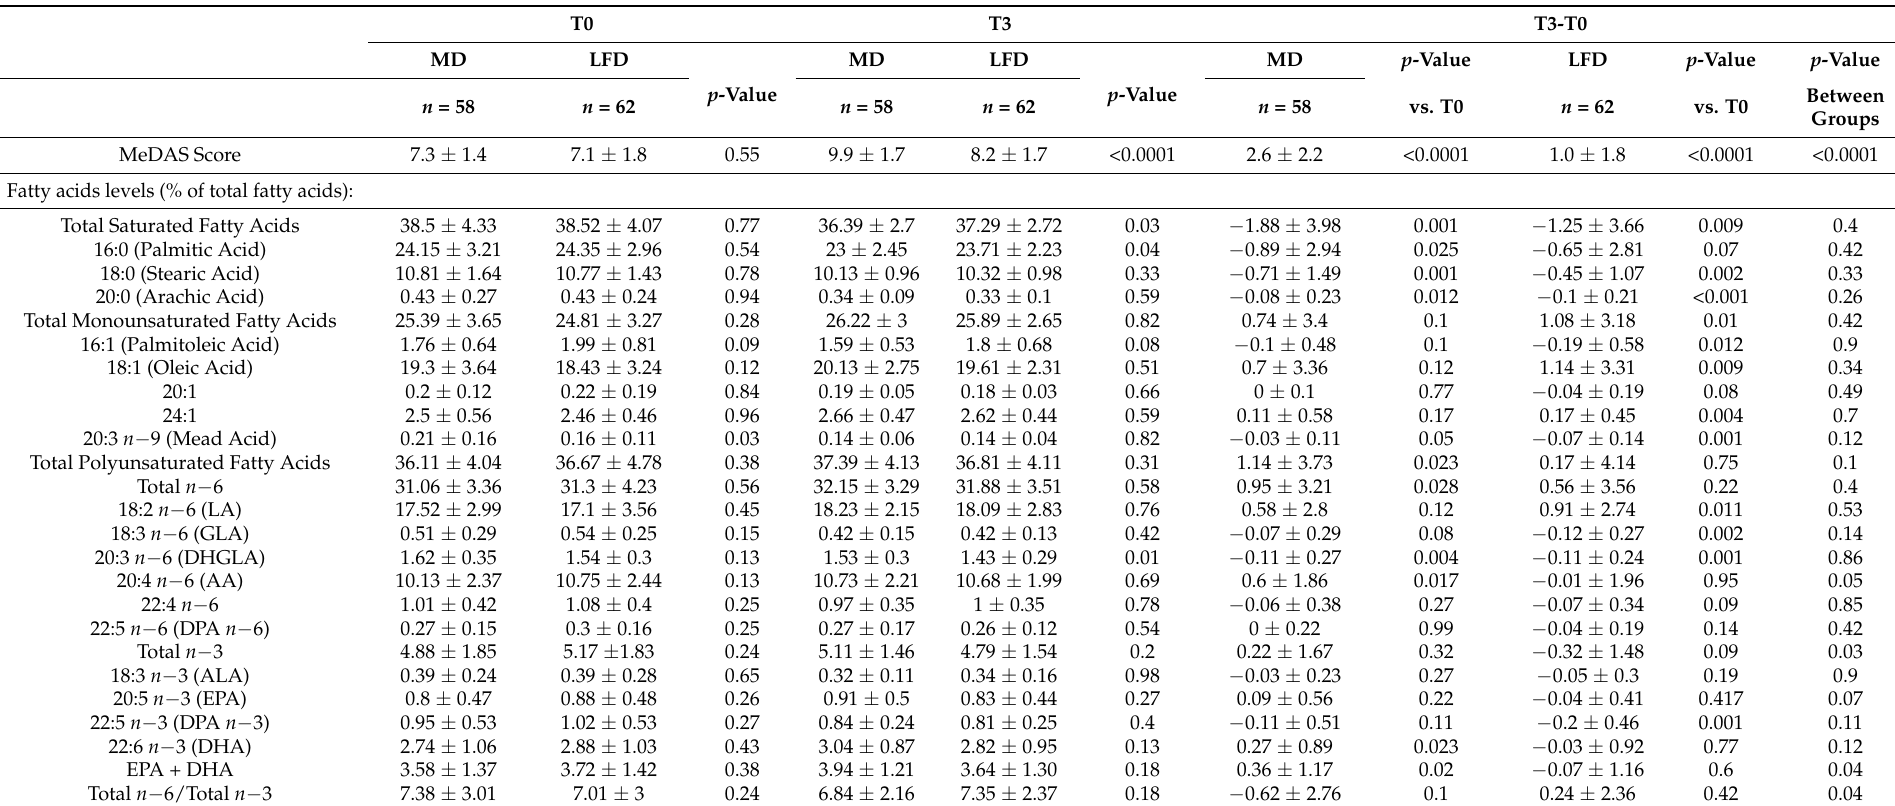
Table 2. Diet Mediterranean-ness and levels of fatty acids (%) of patients stratified per treatment arm at time T0, T3 and variation